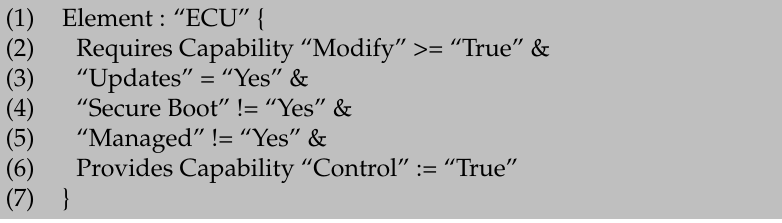
Figure A3. Anti-Pattern for Rule